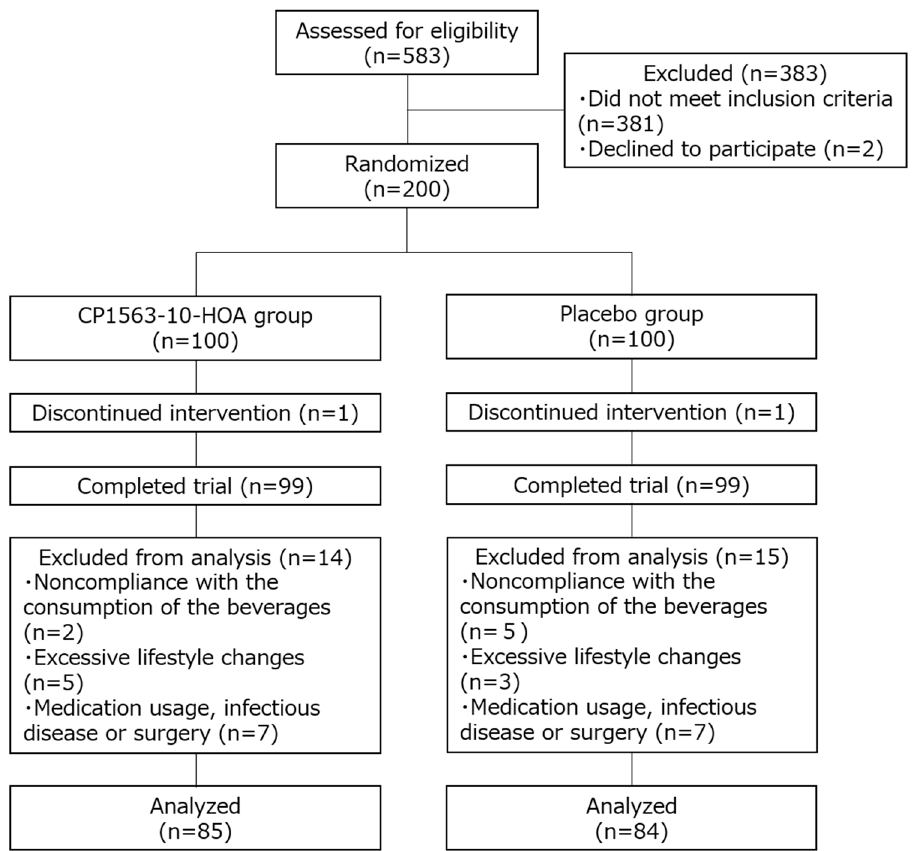
Figure 1. Flow diagram of the progress stages of this study.